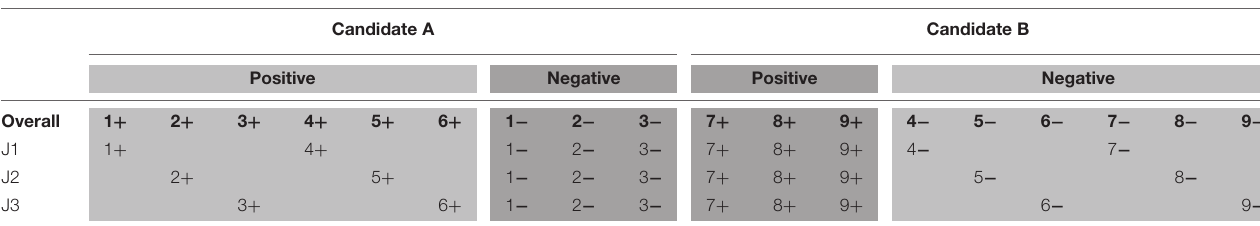
TABLE 1 | Structure of a hidden-profile